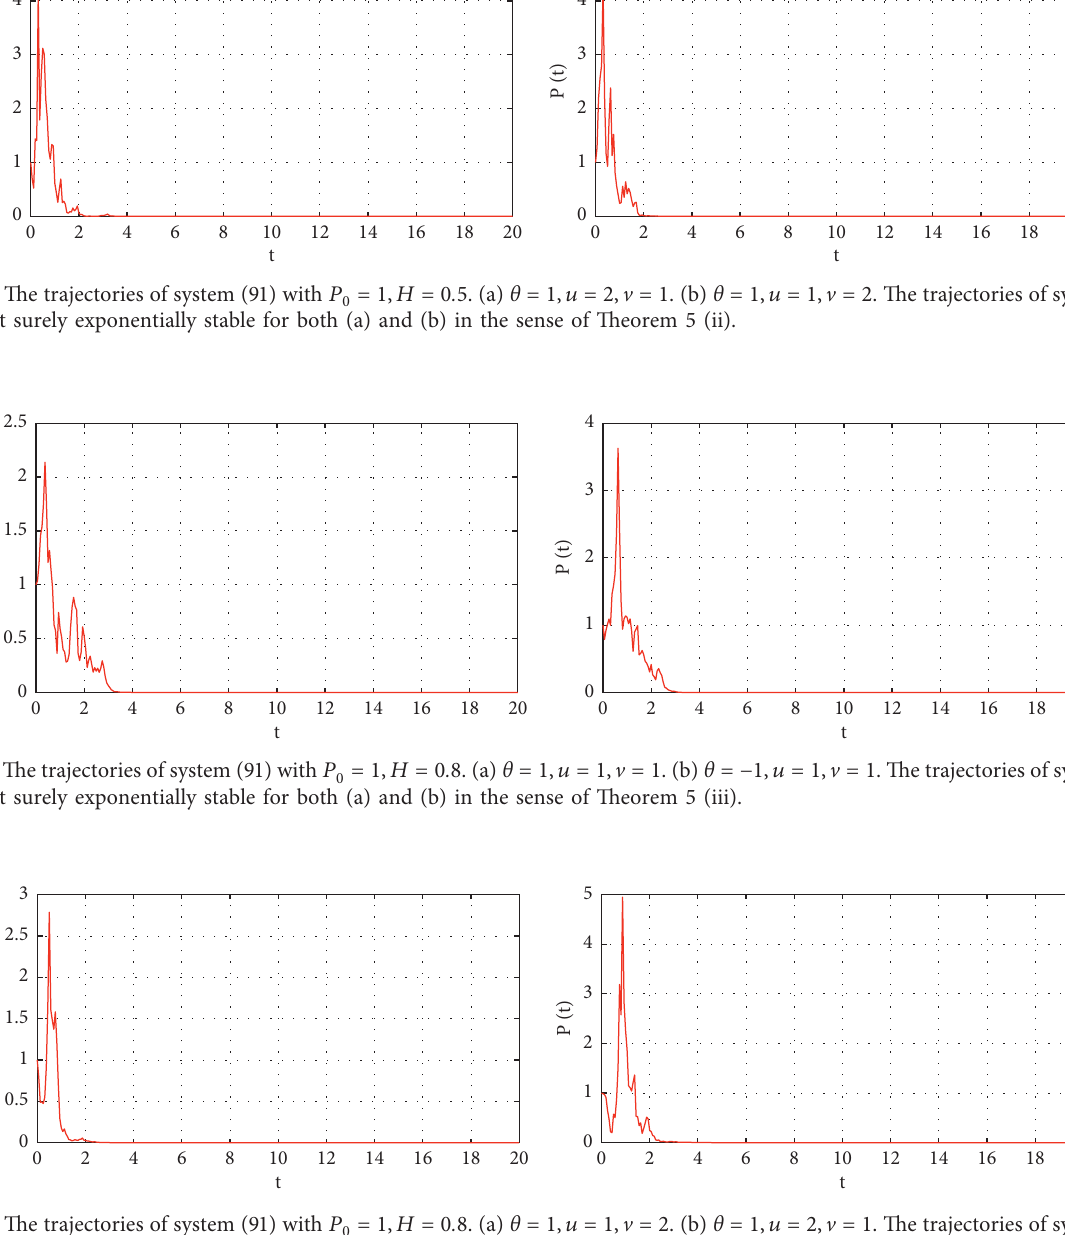
Figure 6: The trajectories of system (91) with P � 1 ,H � 0 . 8. (a) θ � 1 ,u � 1 ,v � 2. (b) θ � 1 , u � 2 ,v � 1. The trajectories of system (91) 0 are almost surely exponentially stable for both (a) and (b) in the sense of Theorem 5